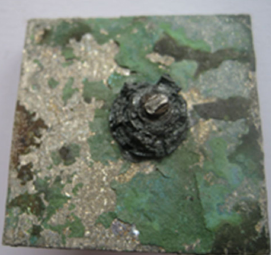
Figure 12. Photo of the FeAl intermetal sample after exposure in the boiler combustion chamber.